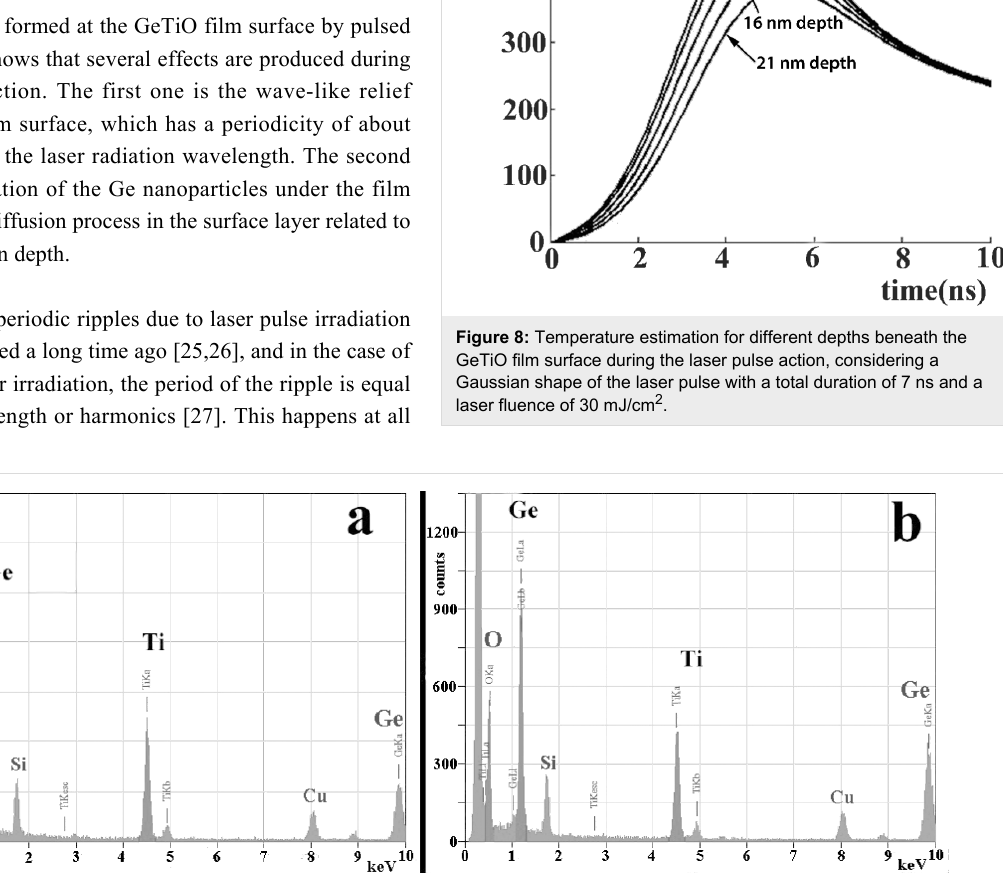
surface layer affected by the laser radiation, and 2/3 of it can be segregated in amorphous Ge nanoparticles.